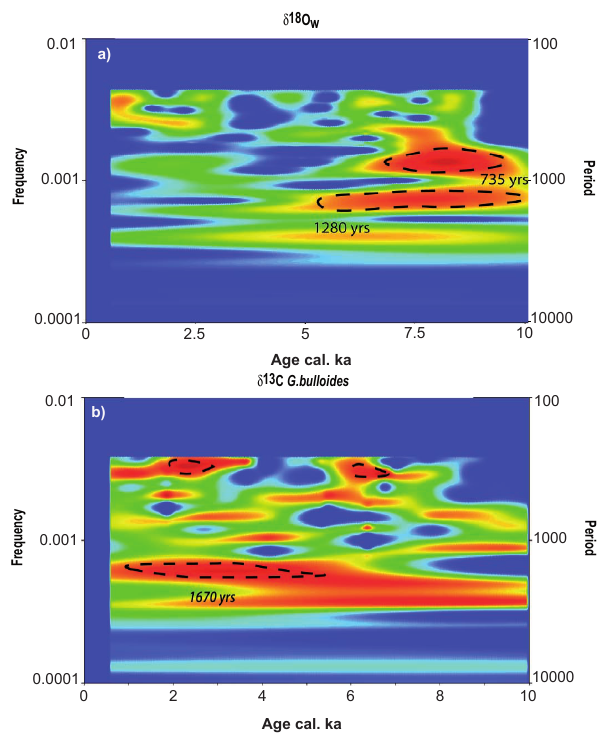
Fig. 7. Wavelet spectrum of the MD90-917 marine hydrological record for (a) δ 18 O w /salinity and (b) δ 13 C Globigerina bulloides . The 95% confidence level is indicated by a dashed